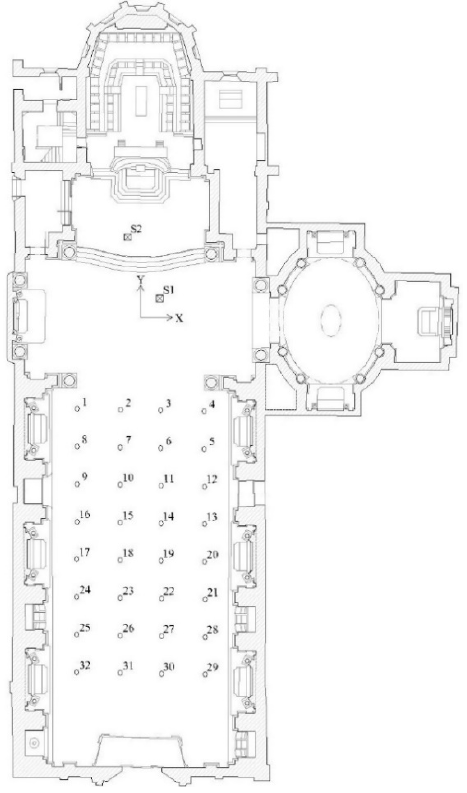
Figure 4. Source and receiver positions inside S. Dominic of Imola.